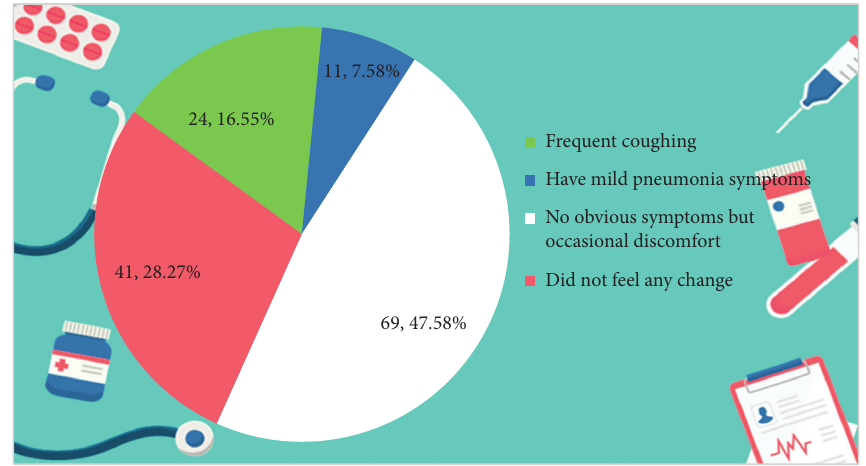
Figure 4: Changes in body comfort of patients with dyslipidemia before and after